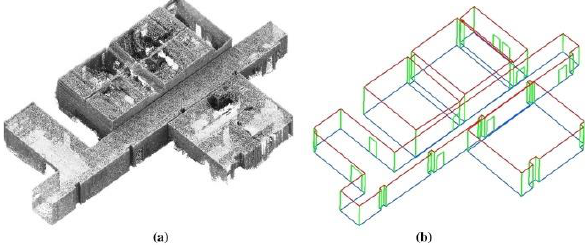
Figure 11. BIM feature examples. (a) Point cloud data. (b) BIM structure model. The green lines are doors and pillars. The red lines are ceilings. The blue lines represent the